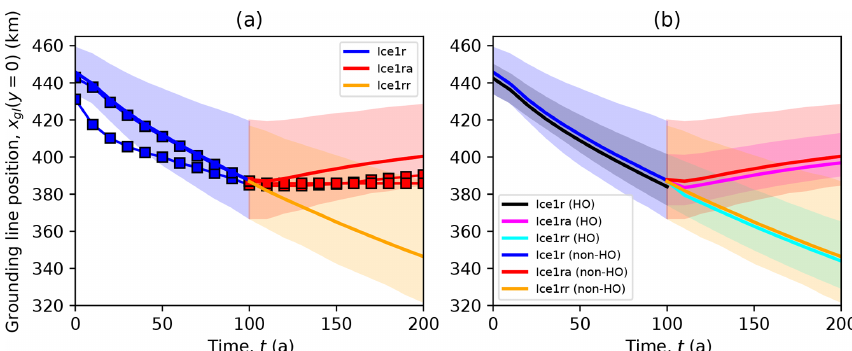
Figure 9. Ice1 midchannel grounding line position plotted for Stokes, higher-order, and other models. The two full-Stokes models (symbols and lines, left panel) see a comparable rate of retreat to the main subset (shaded regions, panel a ) in Ice1r but a much lower rate of advance in Ice1ra. Within the main subset, higher-order models (HO, panel b ) behave in essentially the same way as the other models (non-HO, panel b ).